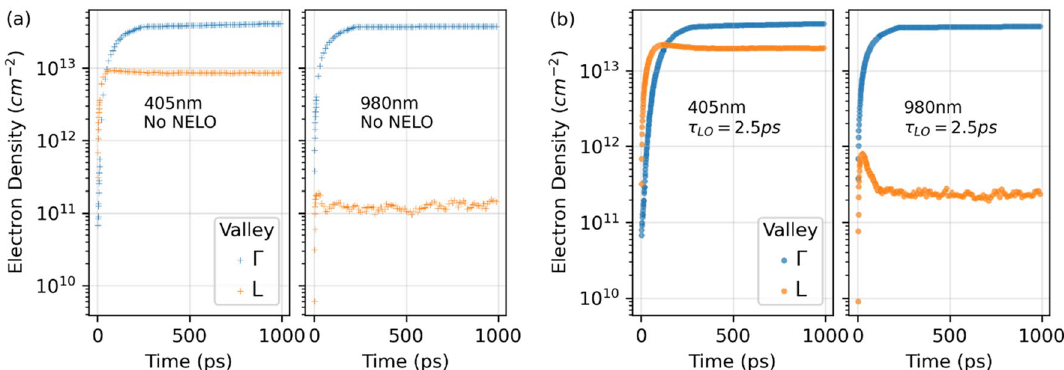
Figure 3. EMC time evolution of electron densities in the Ŵ and L valleys under 405 nm and 980 nm CW excitation. ( a ) Results without nonequilibrium LO phonons. ( b ) Results with nonequilibrium LO